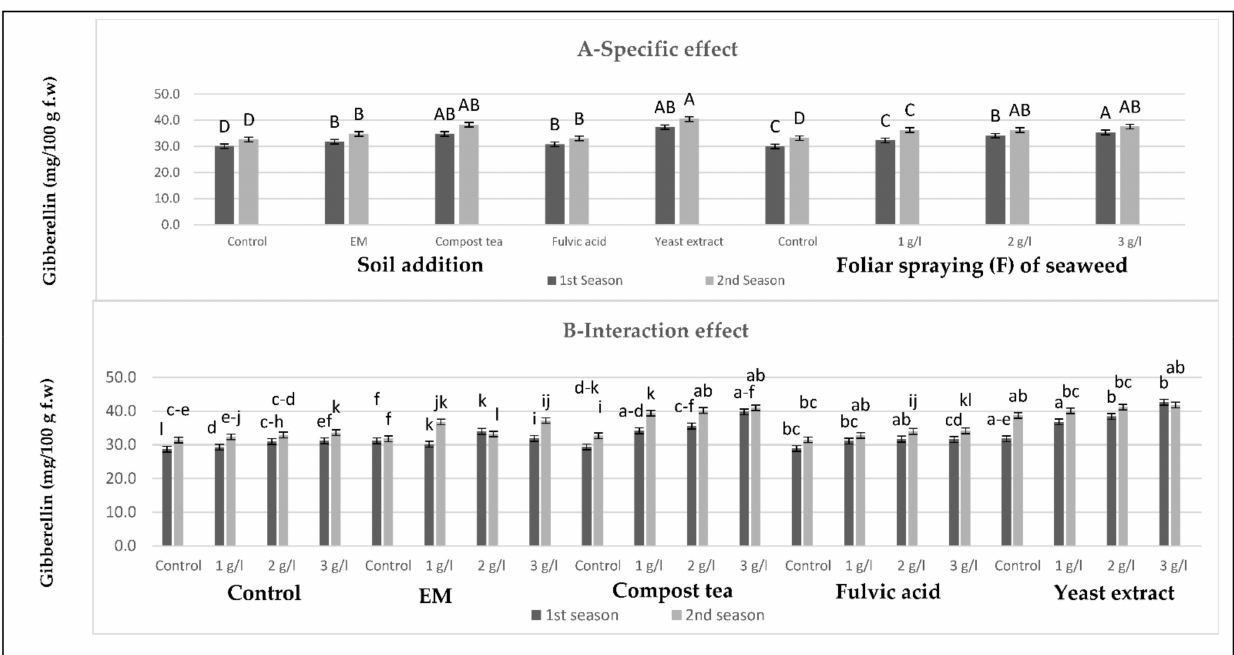
Figure 3. ( A , B ) Effects of soil addition of EM, compost tea, fulvic acid, yeast extract, and foliar spray with seaweed extract and their combinations on the cytokinins (mg/100 g f.w) of sweet pepper plants during the 2019/2020 and 2020/2021 seasons. Specific effects are indicated with uppercase letters and the interactions are indicated with lowercase letters, unless otherwise mentioned, according to Tukey’s multiple range test (TMRT) at p ≤